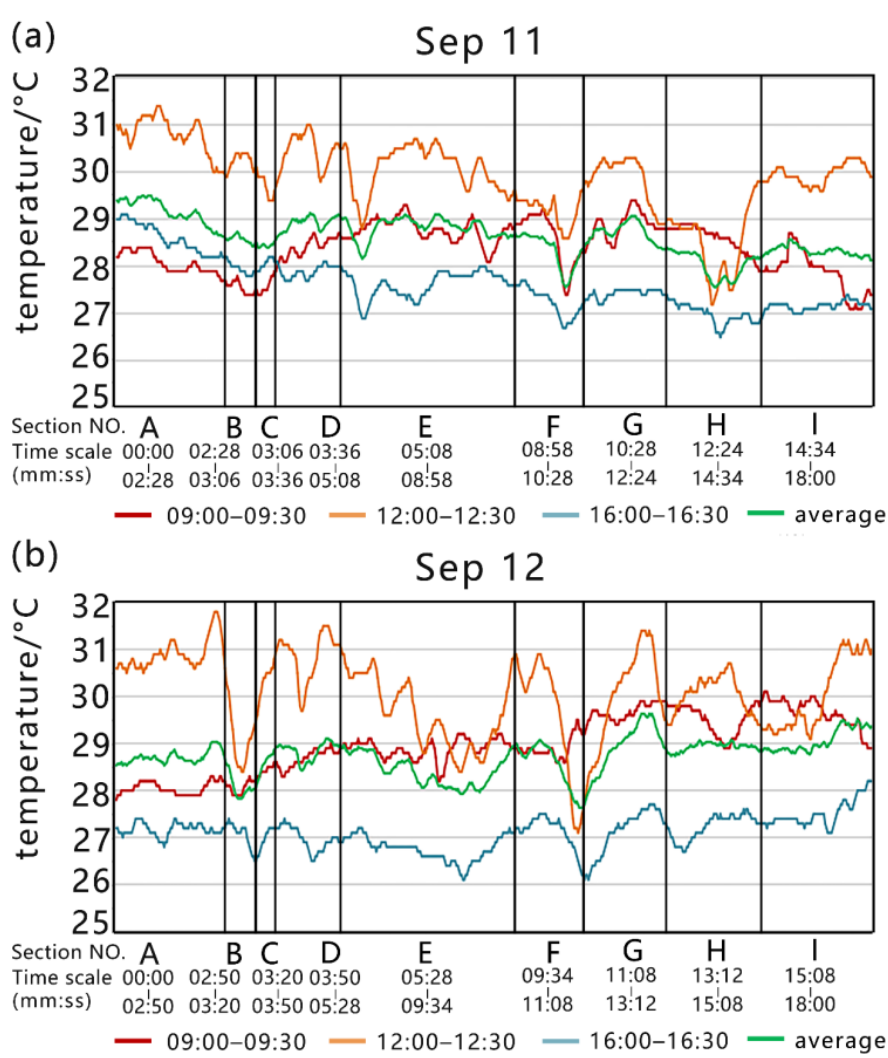
Figure 7. The line charts depicting the air temperature changes over three time periods on 11 September ( a ) and 12 September ( b